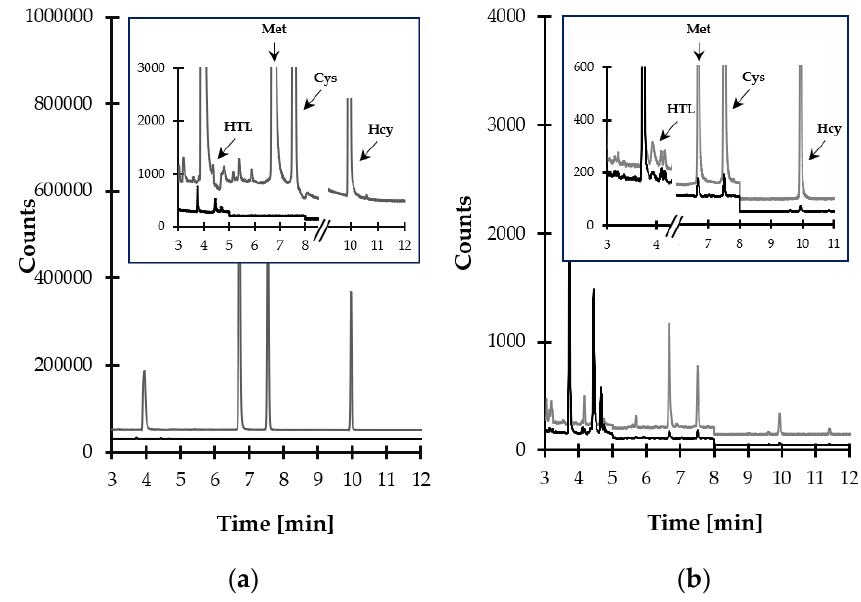
Figure 7. Representative chromatograms of standard solutions and human saliva prepared according to the procedure described in Section 3.5. Chromatographic conditions were as described in Section 3.6. ( a ) Blank standard solution (black line) and standard solution of HTL, Met, Cys, and Hcy (10 µ mol L − 1 ) (grey line); ( b ) normal human saliva sample (black line) and the same sample spiked with the analytes (10 µ mol L − 1 ) (grey line). Table 1. Analytical characteristics of HTL/Met/Cys/Hcy-TMS derivatives using SIM MS mode.